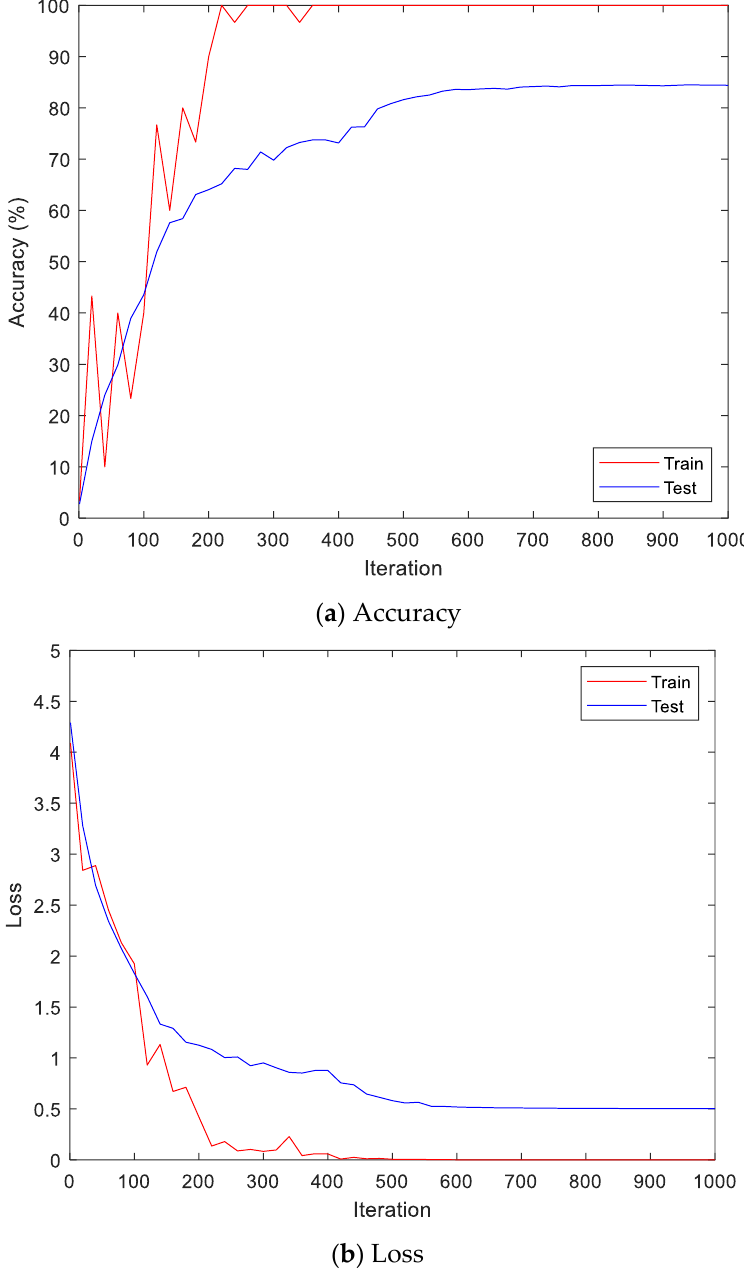
Figure 9. Training process by the scalogram and CNN-based individual identification model (Angeles EMG dataset).